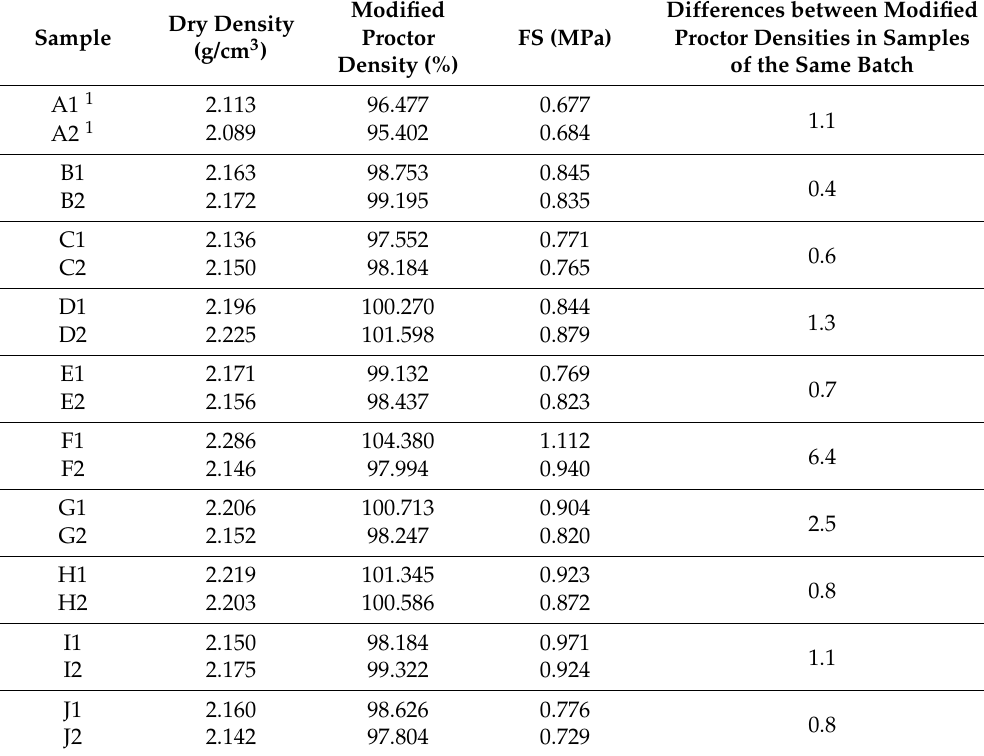
Table 4. Flexural strength (FS) results on prismatic samples at 90